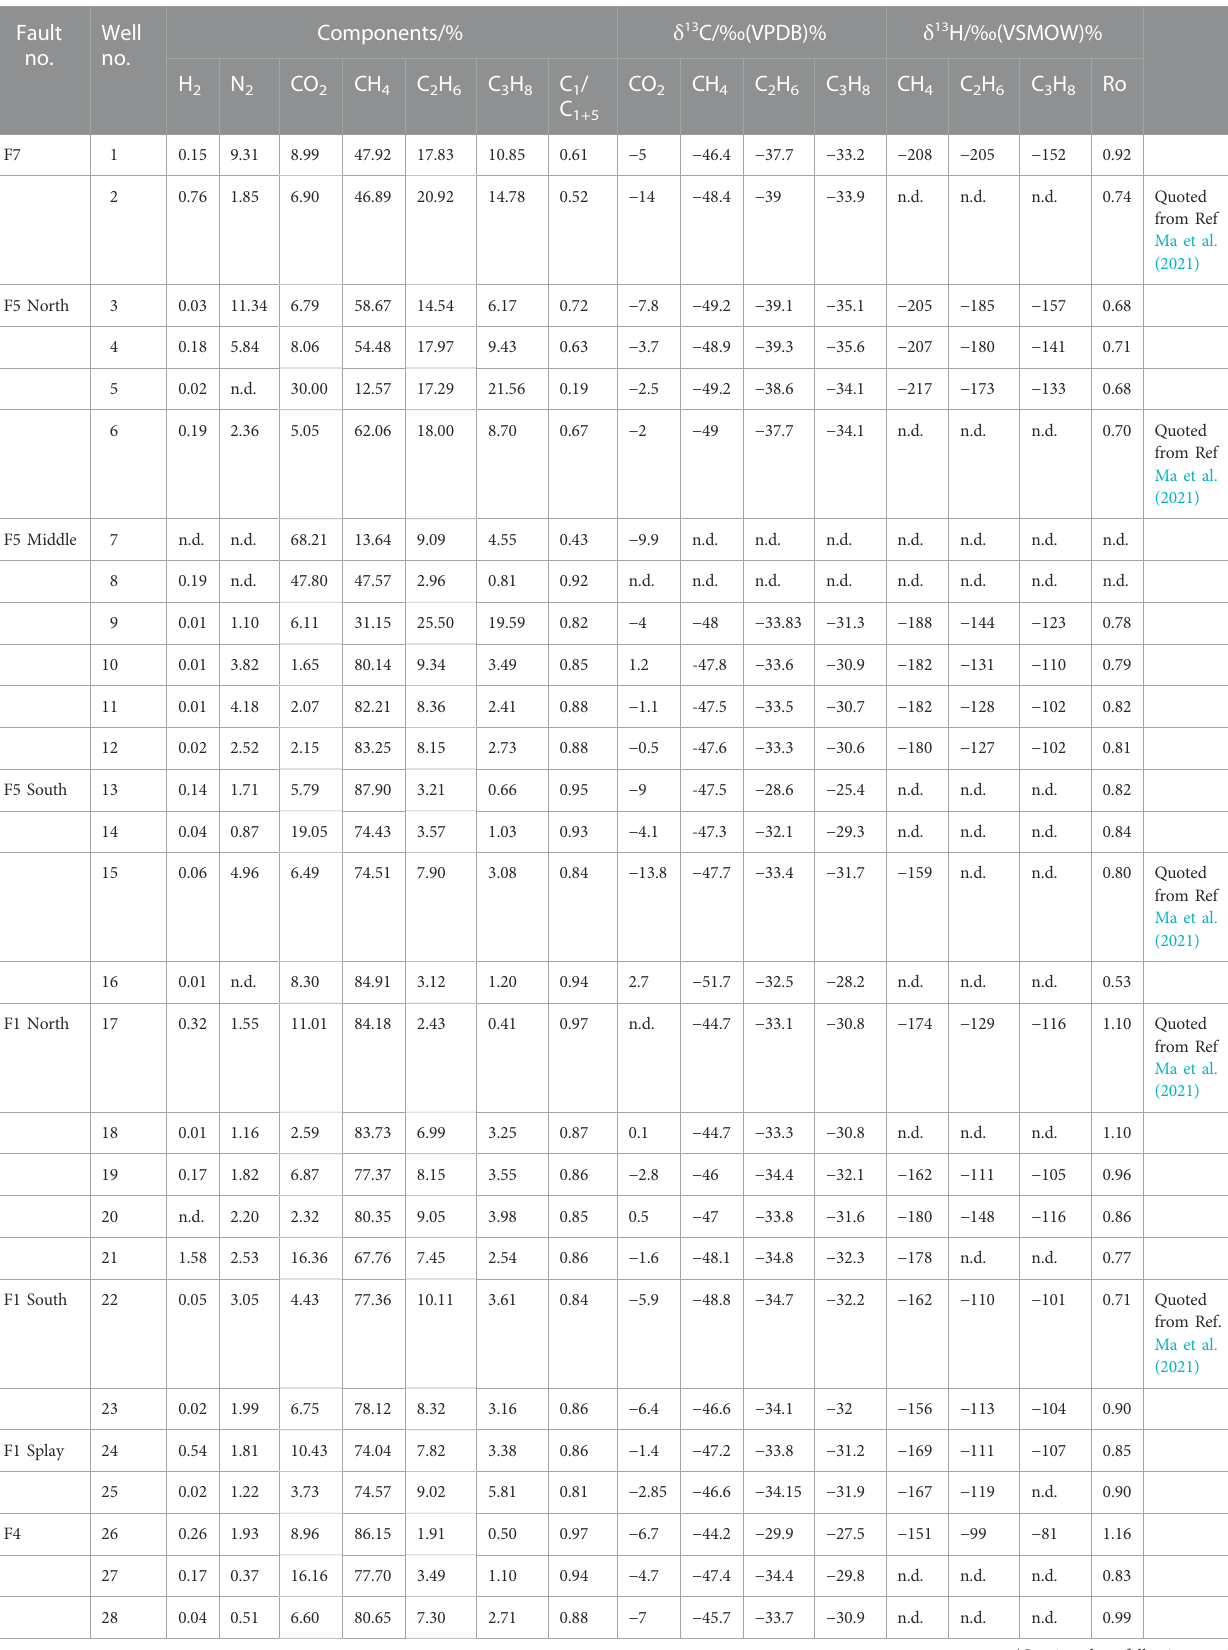
TABLE 1 Molecular and stable carbon isotopic compositions of natural gases from Shunbei area. Fault Well no.